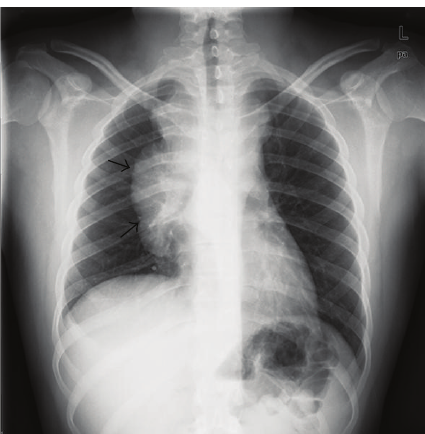
Figure 1: Chest radiograph at initial presentation showing large right hilar mass with right paratracheal soft tissue mass (see arrows).